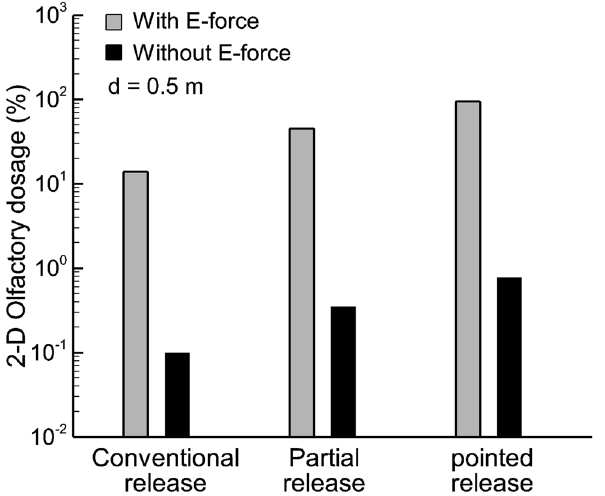
Figure 5. Comparison of olfactory dosages with and without electric forces in the 2-D model on a logarithmic scale. The olfactory dosages can be two orders of magnitude higher with applied E-forces than